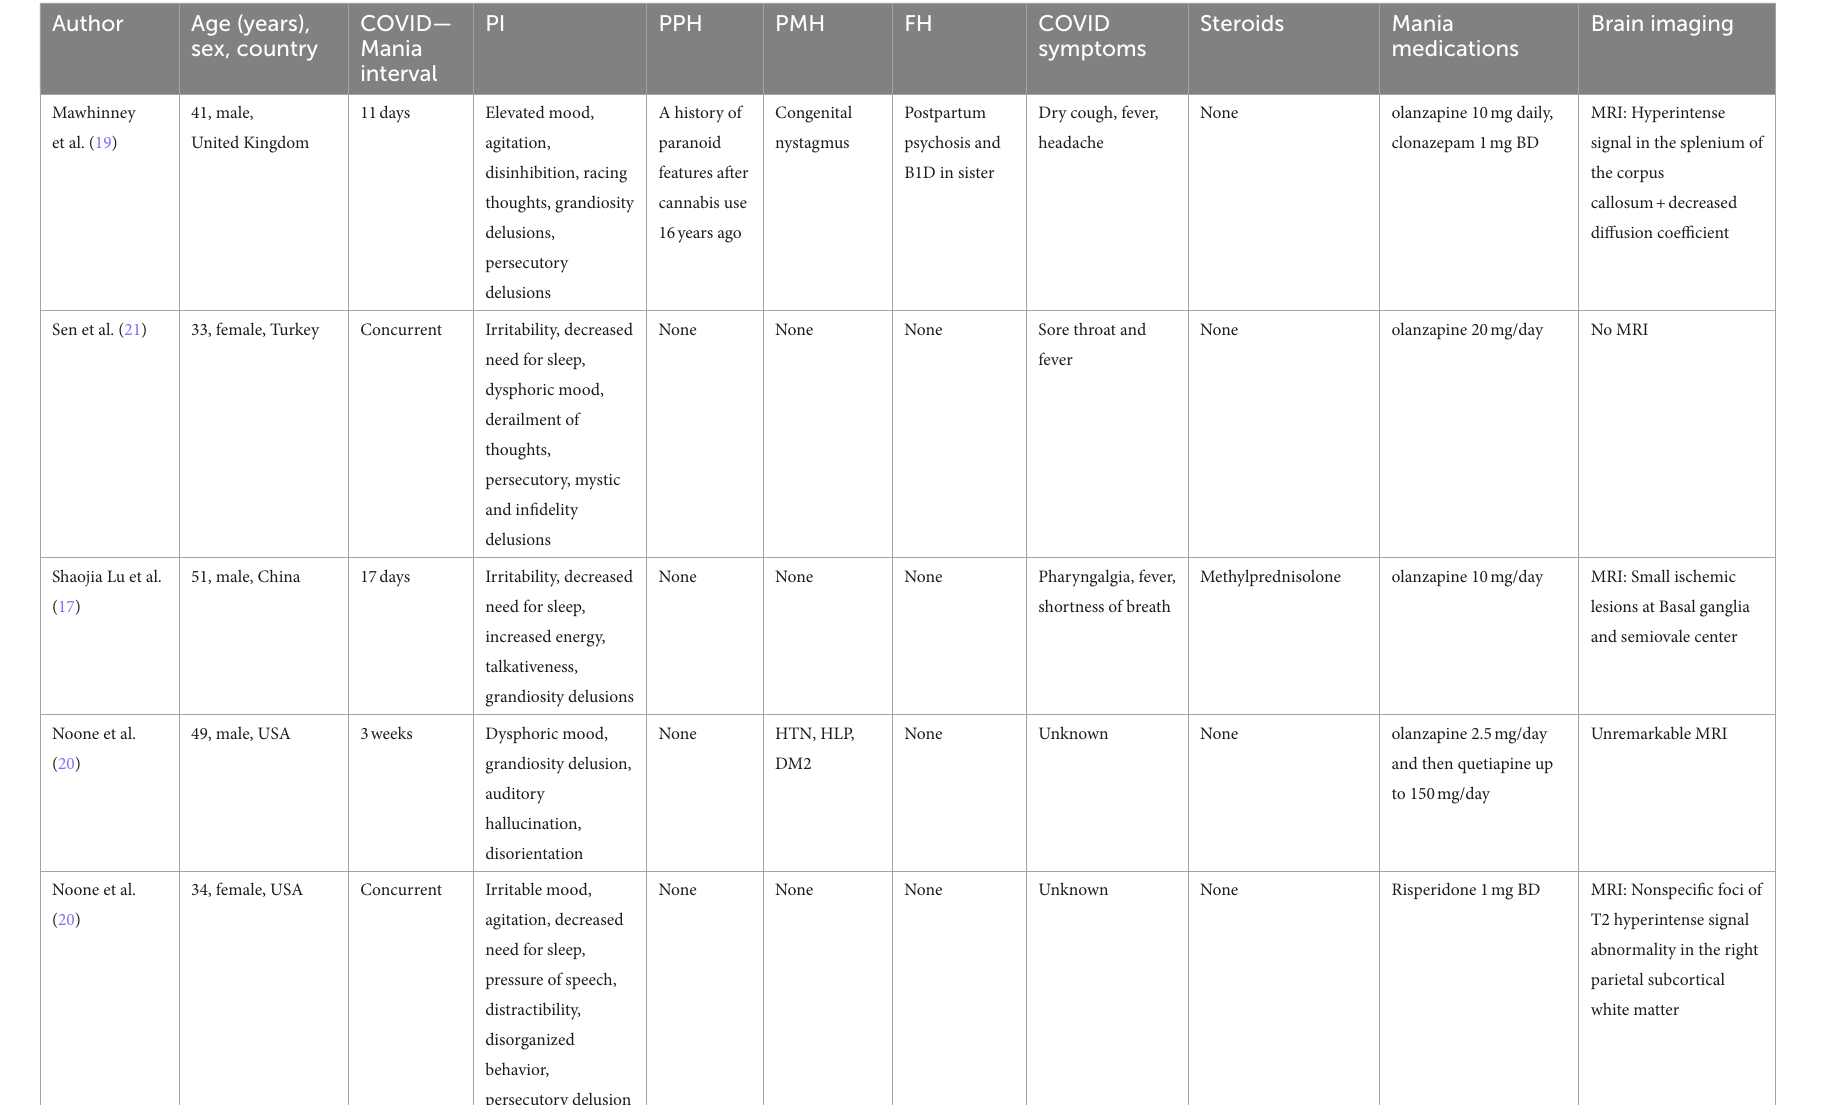
TABLE 2 A review of previously studied post-COVID manic